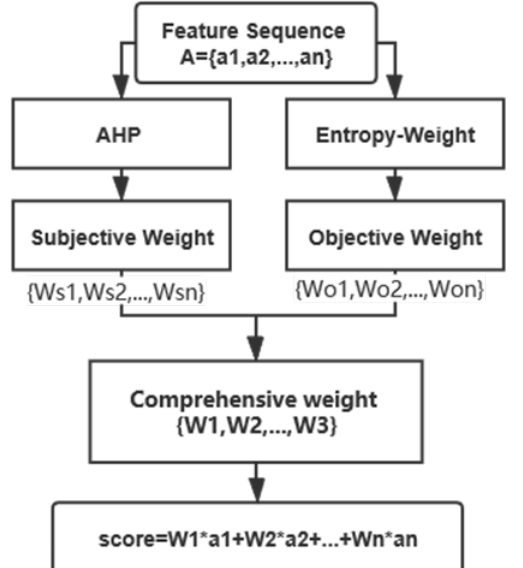
Figure 4. The structure of statistical modeling.